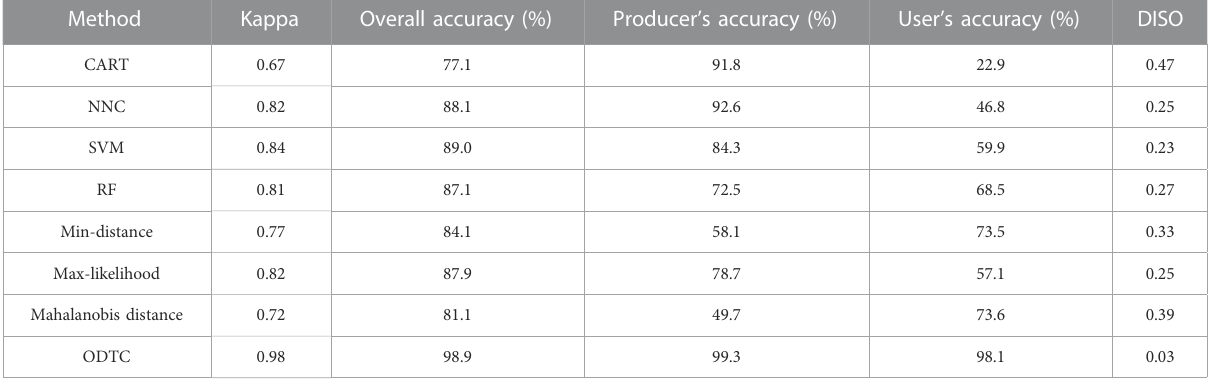
TABLE 7 Results of remote sensing classi fi cation of wetlands in the study area using eight